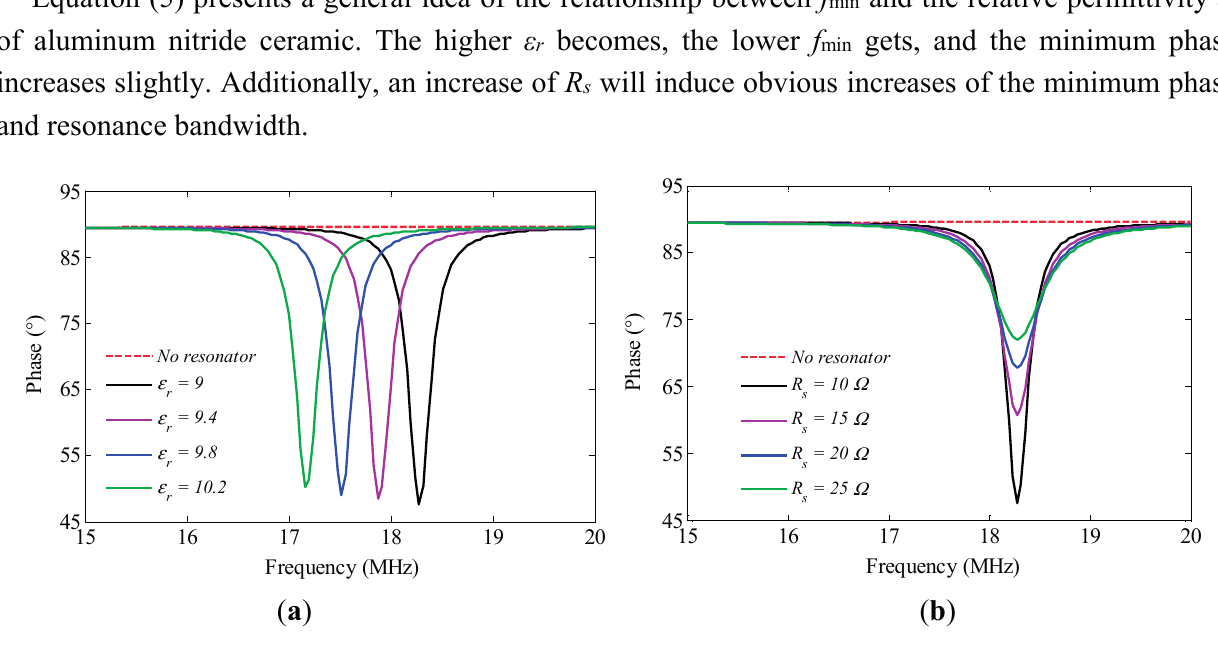
Figure 2. The simulation phase of Z versus frequency at different ε r ( a ) and R s ( b